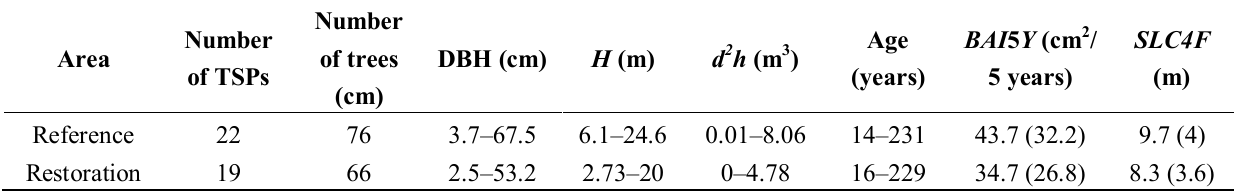
Table 1. Characteristics of the temporary sample plots used in this study in the reference and restoration areas. Ranges give the minimum and maximum values. Standard deviations are given in brackets next to the mean value. Abbreviations: TSP = Temporary Sample Plot, DBH: Diameter at breast height, H: Total tree height, d 2 h : DBH 2 × H , BAI 5 Y : ring are increment over the last 5 years; SLC4F : sum of longest clearbole sections on each of the four